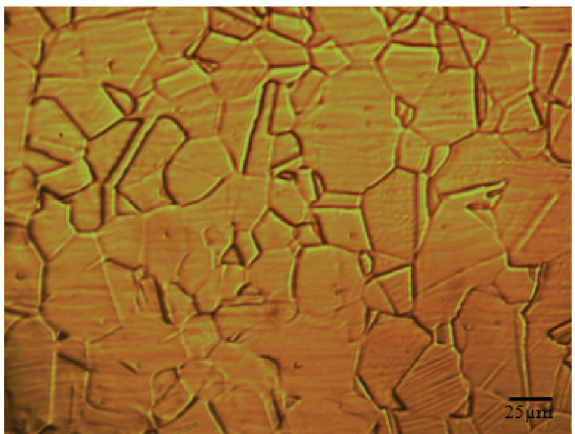
Figure 2: Light optical micrograph of the substrate material.